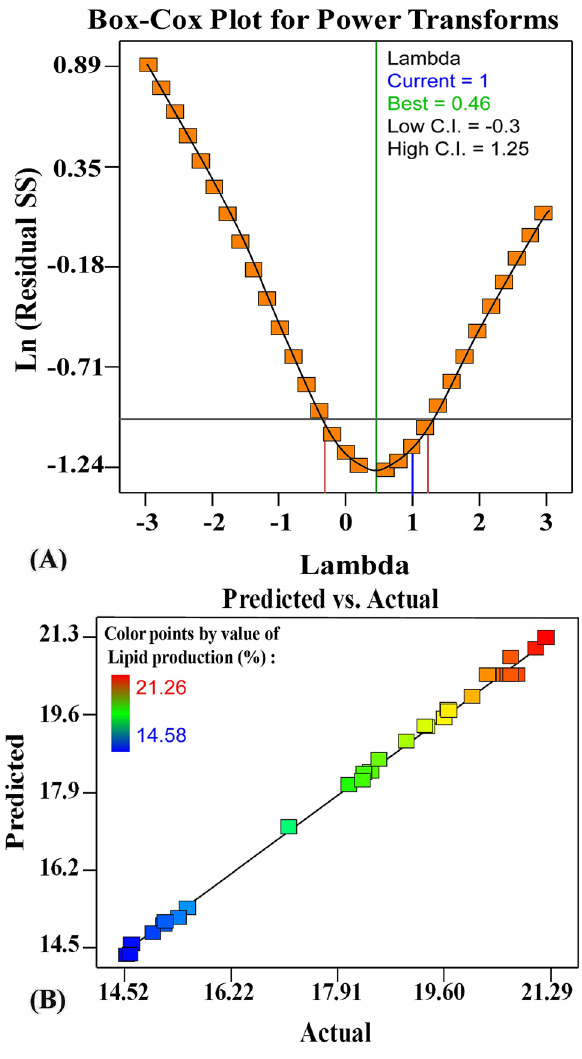
Figure 3. ( A ) Box–Cox plot of model transformation and ( B ) plot of predicted versus actual values of lipid production (%) by using Scenedesmus obliquus as determined by a second-order polynomial